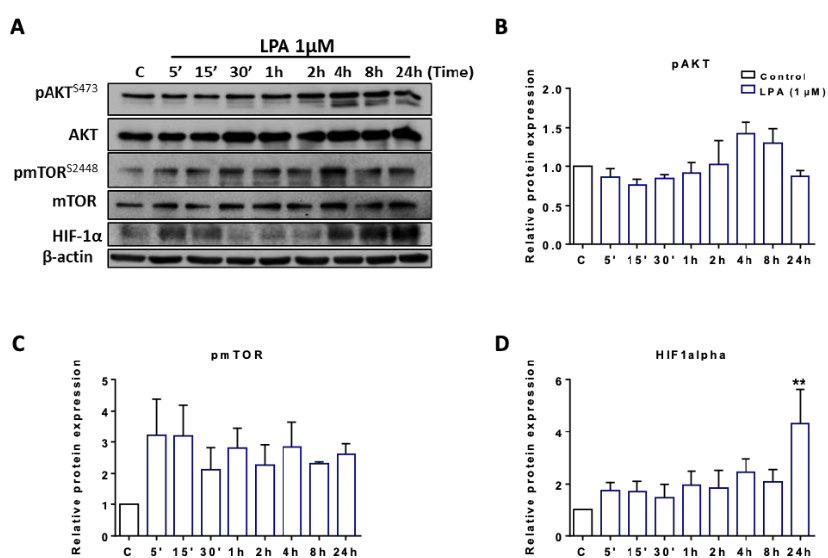
Figure 3. Immunoblot analysis of proteins involved in glycolysis upon treatment with LPA. ( A ) Serum-starved BV-2 cells were incubated in the absence (c) and presence of 1 µ M LPA for the indicated time points. Expression levels of energy/oxygen sensing proteins were examined by immunoblotting. One representative blot out of three is shown. β -actin was used as loading control. Bar graphs represent densitometric analyses of immunoreactive bands of ( B ) phosphorylated AKT (pAKT), ( C ) phospho mTOR (pmTOR), and ( D ) HIF1 α relative to β -actin. Results are presented as mean values ± SEM of 3 independent experiments. (** p < 0.01 compared to control; one-way ANOVA with Bonferroni correction).